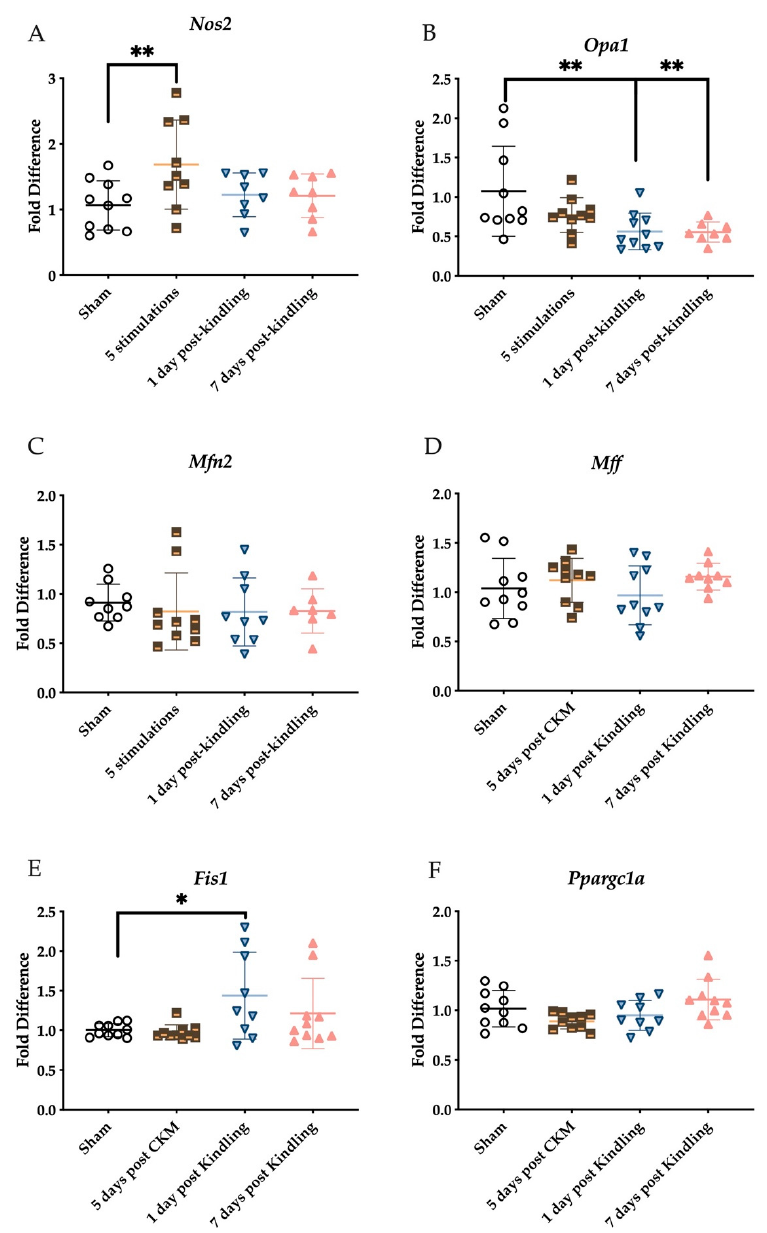
Figure 6. RT-qPCR analysis of genes related to mitochondrial stress normalized to the reference (housekeeping) gene, GUSB, in the whole right hemisphere of the mouse brain following sham or corneal kindling. Data are presented as mean +/ − S.E.M. ( A ) The expression of NOS2 was significantly upregulated in the whole right hemisphere of the mouse brain after five stimulations of corneal kindling but not altered after the acquisition of the fully kindled state. ( B ) OPA1 gene expression was significantly downregulated in the whole hemisphere of the mouse brain after full acquisition of the kindled state but minimally altered after five stimulations, while kindling did not significantly alter the expression of ( C ) MFN2 in the whole hemisphere. ( D ) Mff gene expression in the whole hemisphere was not significantly altered by the corneal kindling process. ( E ) However, expression of FIS1 was significantly affected by the corneal kindling (F (3,35) = 3.519, p < 0.05), with a post hoc test demonstrating elevated expression at 1 day post corneal kindling ( p < 0.05) in the whole right hemisphere. ( F ) The expression of PPARGC1A was significantly different with kindling (F (3,35) = 3.329, p < 0.05), but there were no post hoc differences between groups and sham-kindled mice at any time point. * Indicates significant difference from sham-kindled mice, p < 0.05; ** indicates significant difference from sham-kindled mice, p <